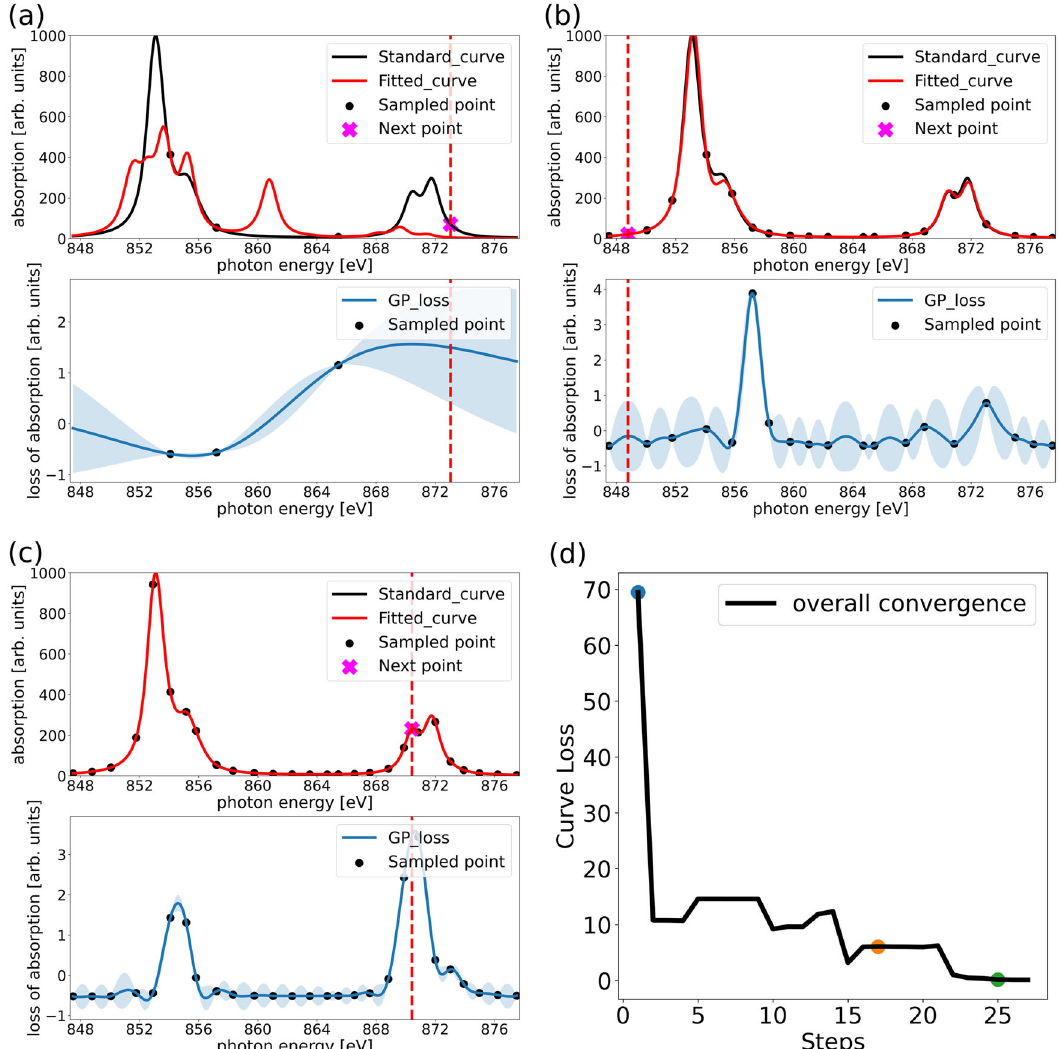
Fig. 1 The CFM model results. The fi tting results of the CFM model for differnet sampling points: a three sampling points (Step 1); b 19 sampling points (Step 17); c 27 sampling points (Step 25); d CFM XAS curve convergence, with the colored dots denote in order the results of Fig. 1a to c. The upper panels in ( a )-( c ) show the fi tted results of fBO, where the black curve denotes the standard real values of the unknown XAS curves, the black dots are the already measured points, the red curve is the fi tted result based on current sampled points using the fBO fi tting, and the magenta cross is the point to be measured in the next round, which is determined by sBO. In the lower panels are the standardized prediction of sBO, where the black dots denote the GP predicted loss with the blue-shaded regions denoting the uncertainties. The parameter comparison for the listed steps is shown in Supplementary Table